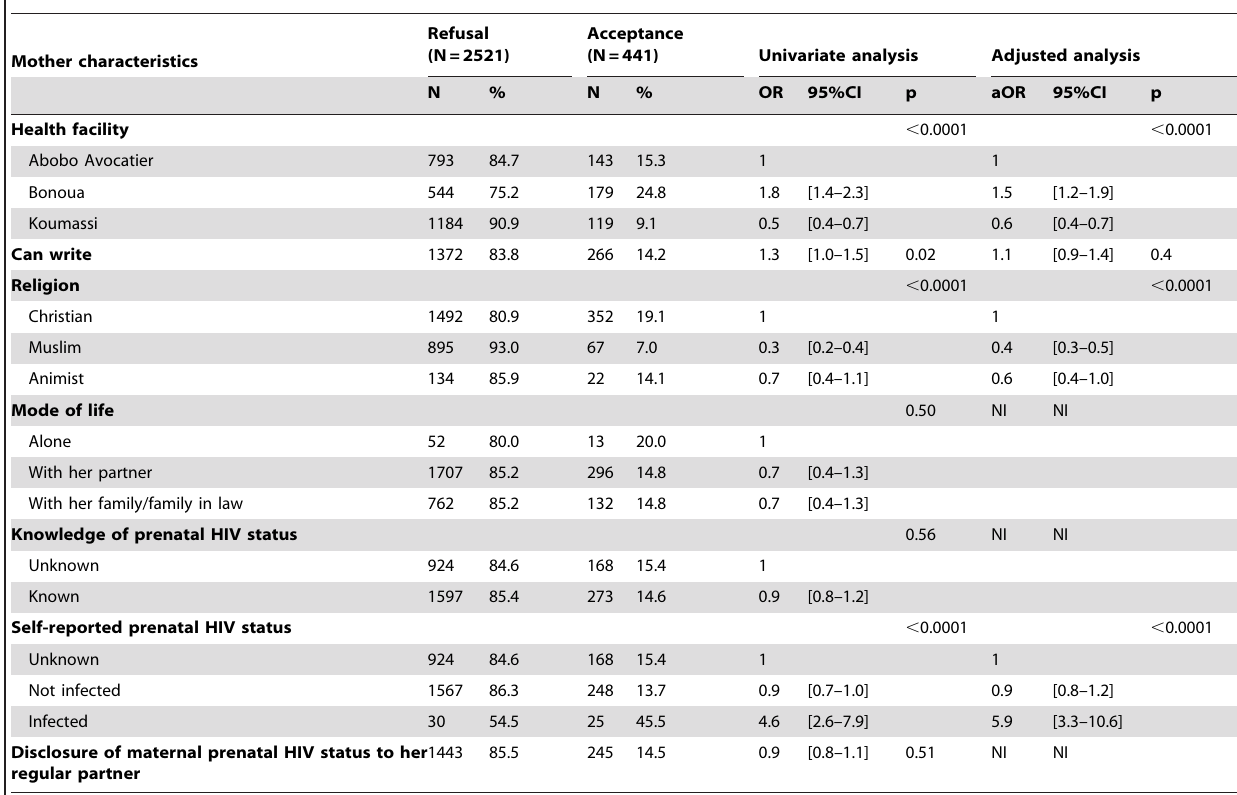
Table 3. Correlates of adequate parental acceptance (n =2962) of infant HIV testing (logistic regression).